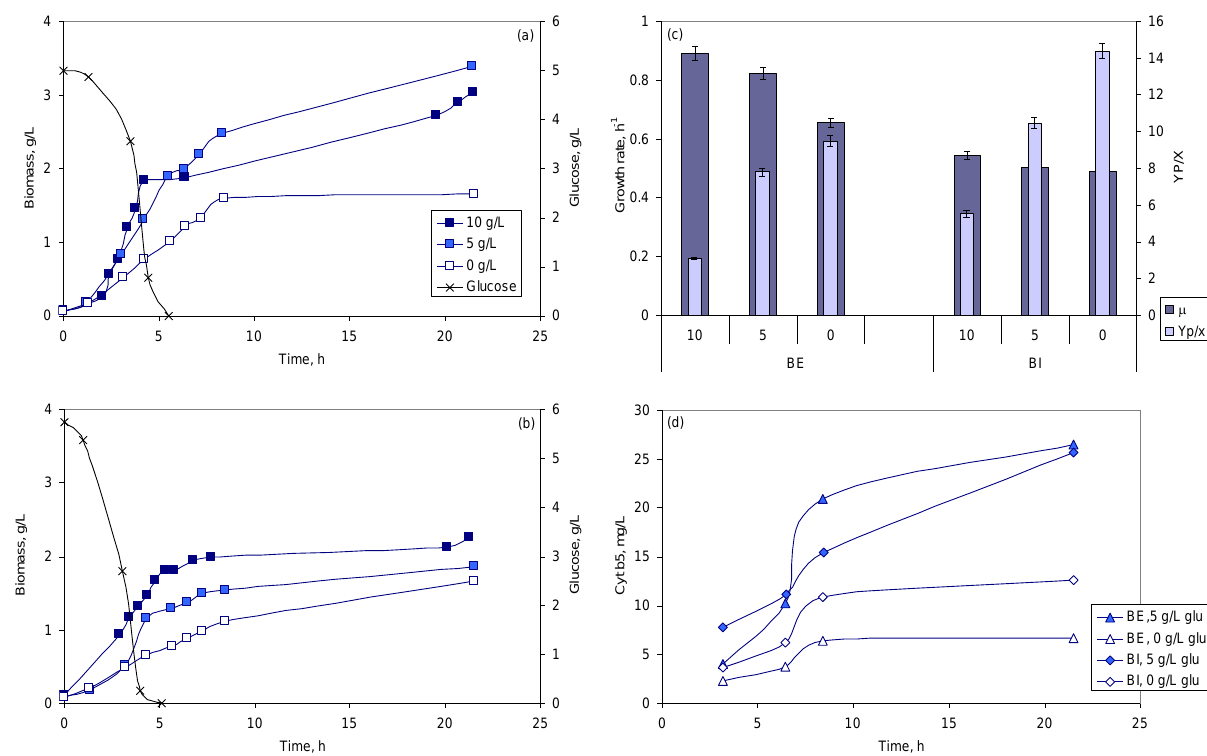
Figure 5. Effect of initial glucose concentration on biomass and cyt b5 production in BE ( a , d ) and BI ( b , d ), and respective growth rate and product to biomass yield ( c ). The maximum standard deviation observed was 10% of the mean value represented.